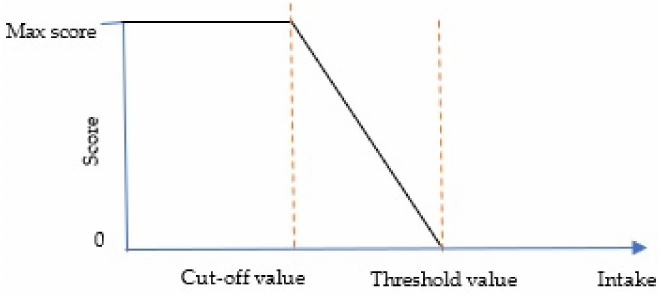
Figure 2. Standard for scoring moderation